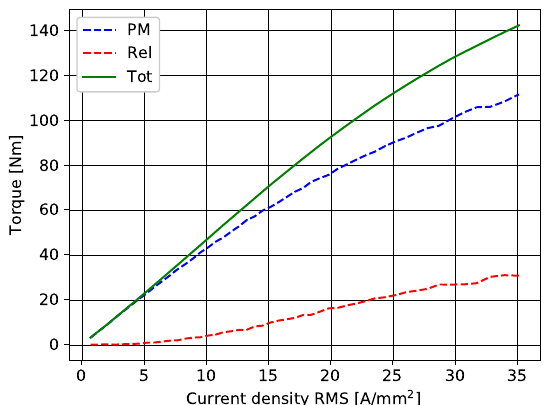
Figure 9. Permanent magnet (PM), reluctance and total torque when operating with optimal MTPA angle as a function of copper RMS current density.